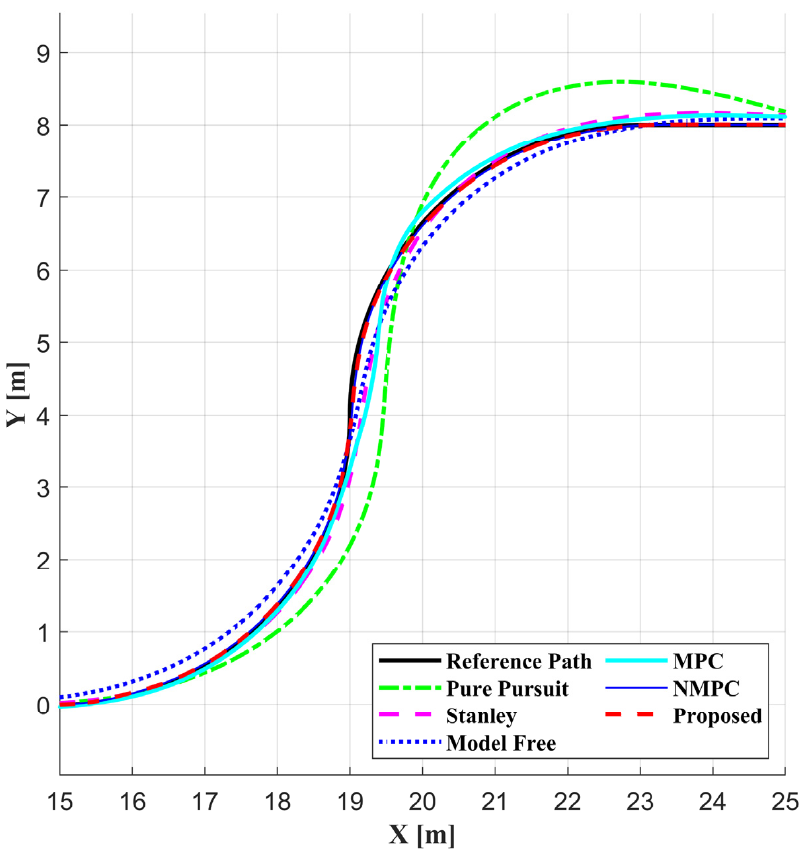
Figure 6. Driving trajectories of each algorithm.